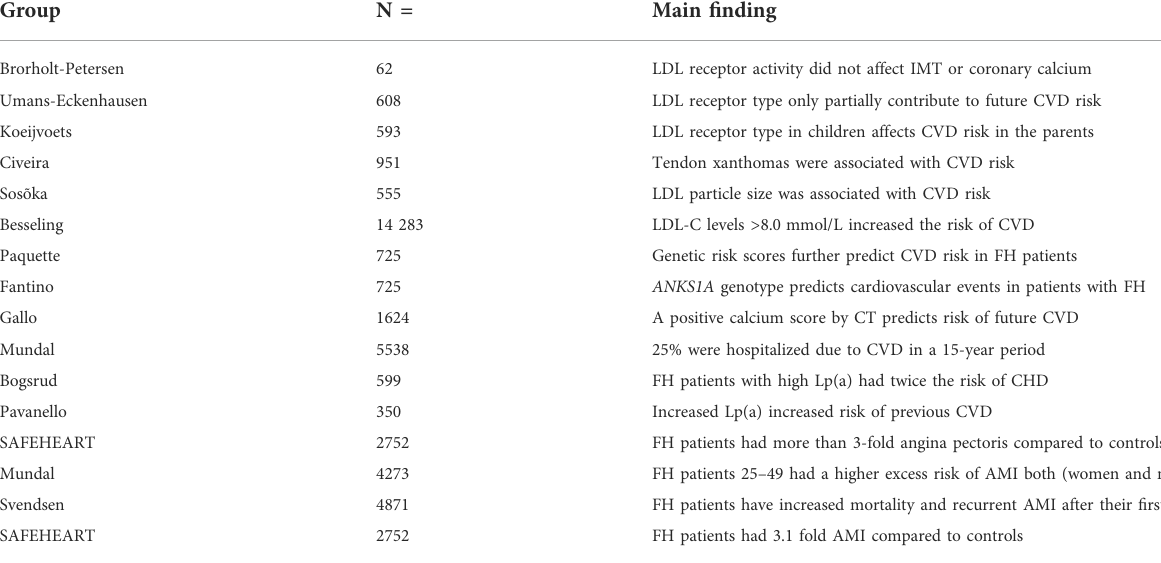
TABLE 1 CVD in mutation FH + patients.